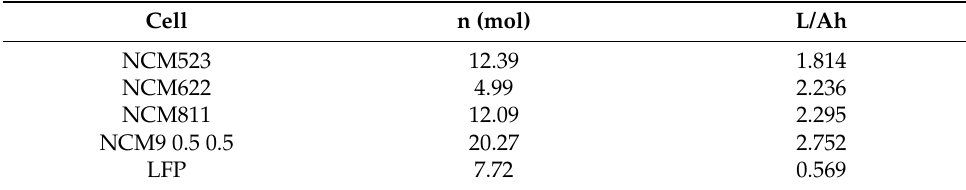
Table 4. Different battery TR gas production and gas production